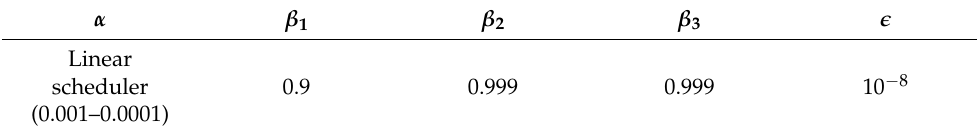
Table 5. Optimiser’s